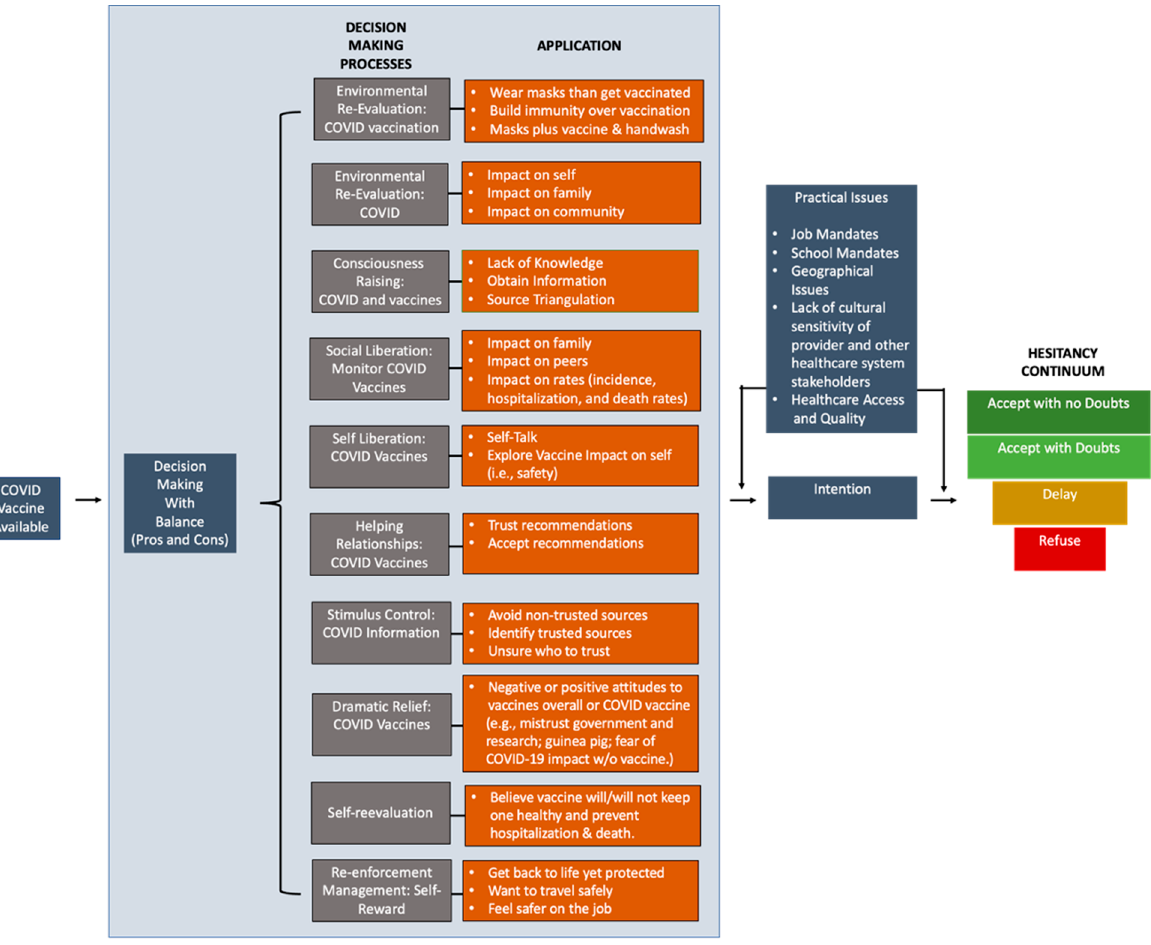
Figure 1. Decision-making processes model (DePC) model for COVID-19 vaccination. Based on Black Americans decision-making processes to be or not be vaccinated.